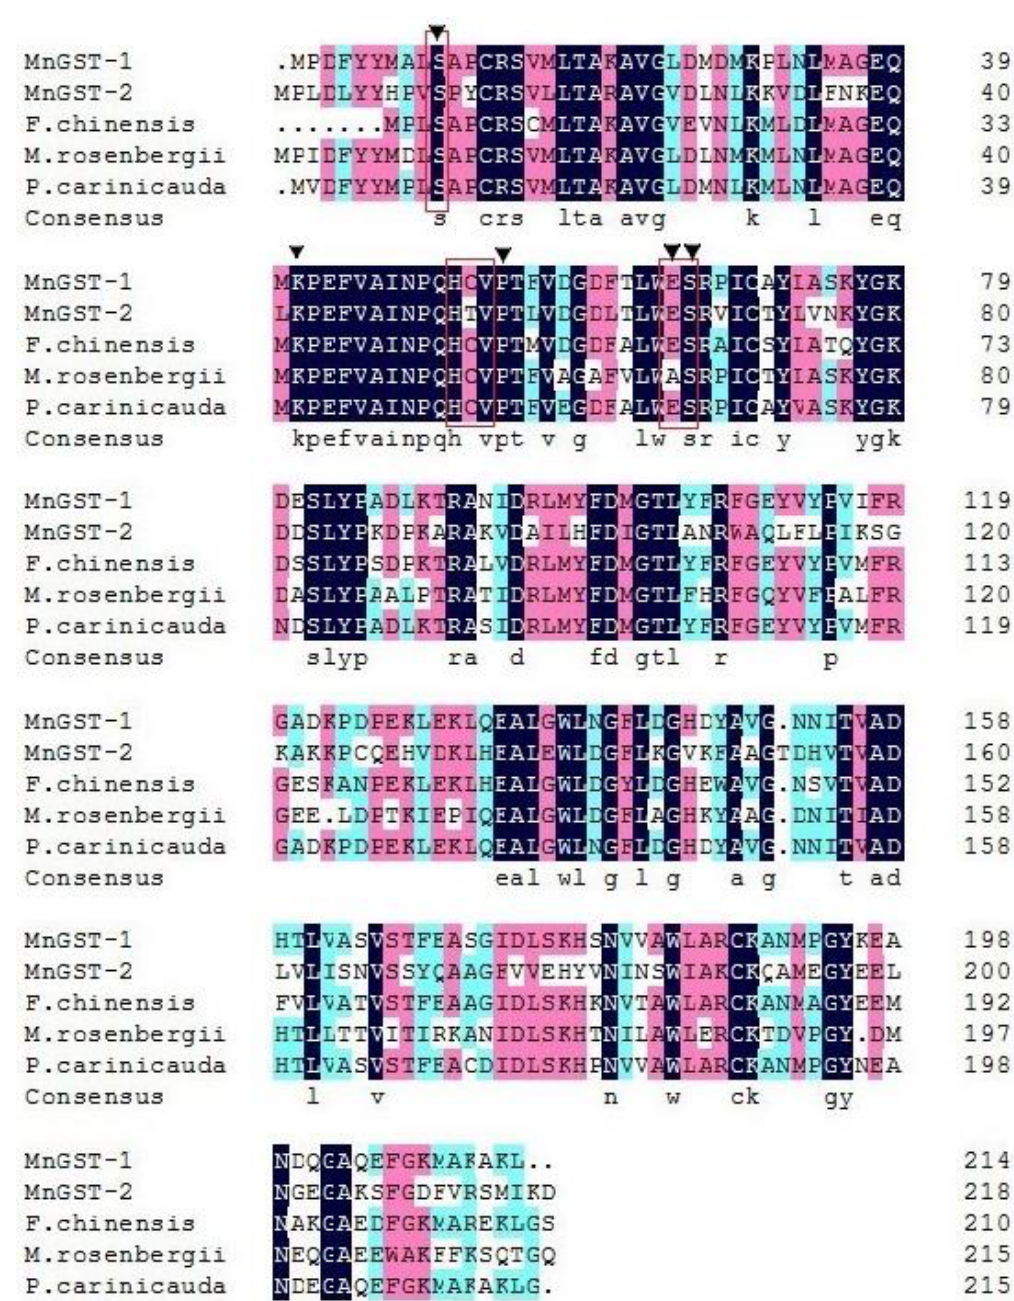
Figure A3. Multiple sequence alignment of the deduced amino acid sequences of Macrobrachium nipponense GSTs with those of other known GSTs. MnGST-1 (GenBank MG787172), MnGST-2 (GenBank MG787173), Fenneropenaeus chinensis (GenBank ANH58178.1), M. rosenbergii (GenBank CCQ19301.1), and Palaemon carinicauda (GenBank AGZ89666.1). Red rectangles indicate N-terminal serines. Black triangles indicate the conserved G-site.